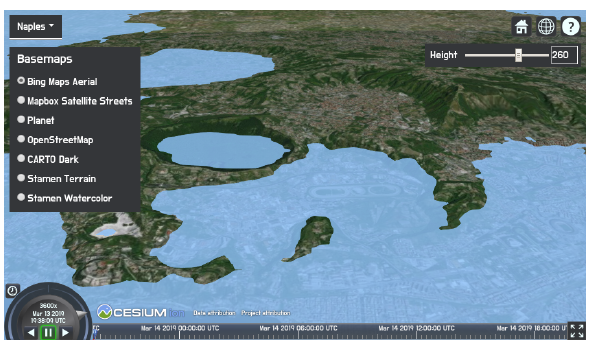
Figure 2. Flood simulation in